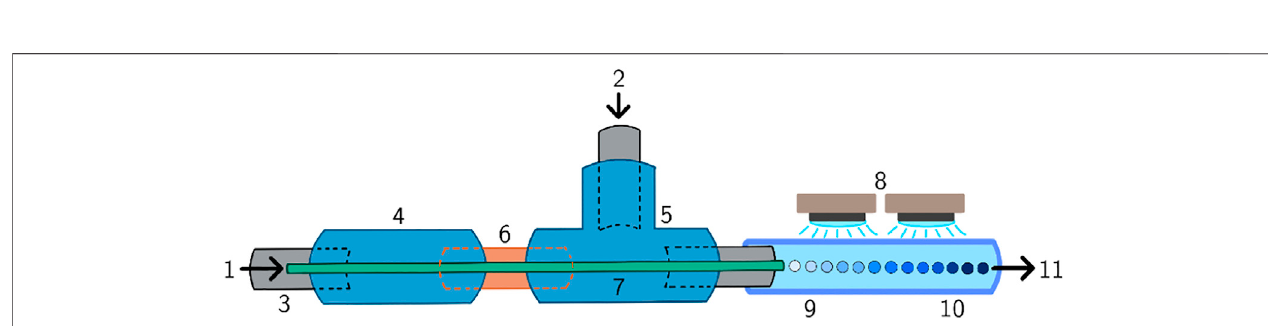
FIGURE 2 | Schematic representation of the micro fl uidic device. (1) Dispersed phase inlet, (2) continuous phase inlet, (3) PTFE tube, (4) connection unit, (5) T-junction, (6) capillary sleeve, (7) capillary, (8) UV LEDs, (9) microdroplets, (10) microparticles, (11) outlet.